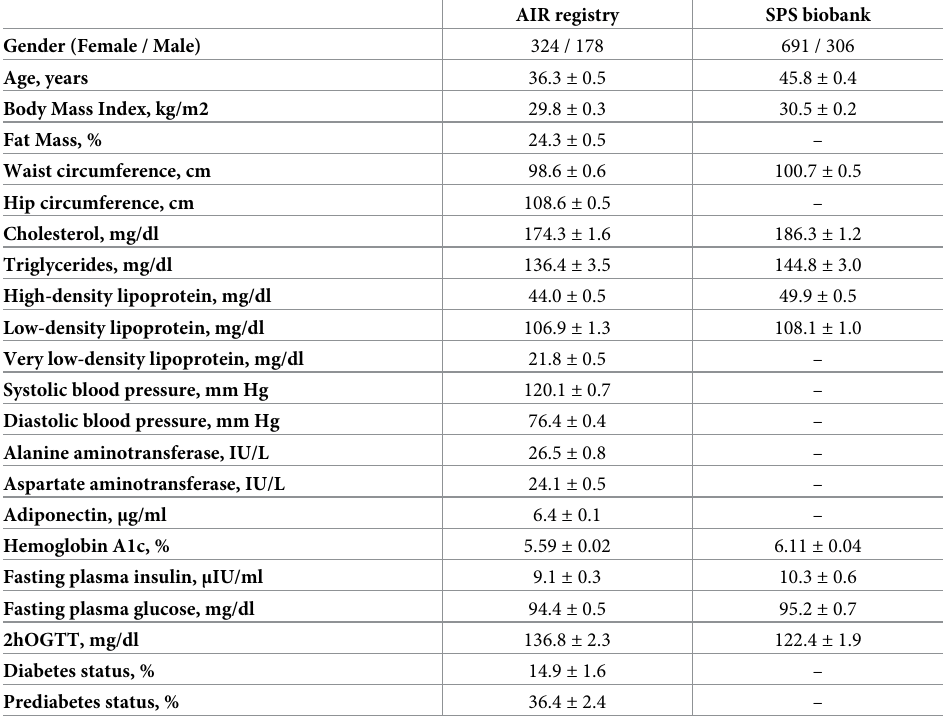
Table 1. Characteristics of the AIR registry and SPS biobank